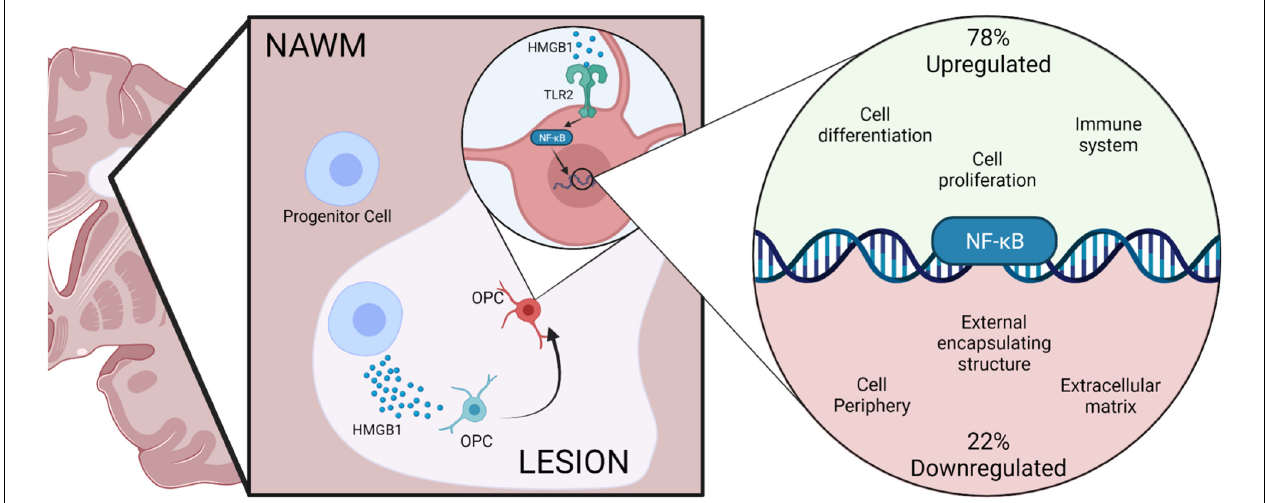
FIGURE 7 | Hypothesized model of HMGB1 inhibitory activity on OPCs in the MS demyelinated lesion environment. Graphical representation of a demyelinated lesion in the MS brain and how expression of HMGB1 negatively impacts the remyelinating potential of OPCs. The stepwise progression from the MS brain (right) to the demyelinated lesion environment (middle panel) where HMGB1 is expressed at higher concentrations, to the intracellular response of OPCs (right panel) depicting a transcriptional influence of HMGB1 on NF κ B gene expression regulation. Results from this study implicate TLR2-mediated receptor activation of NF κ B gene target pathways as putative negative regulators of HMGB1 in the MS brain lesion environment. Created with